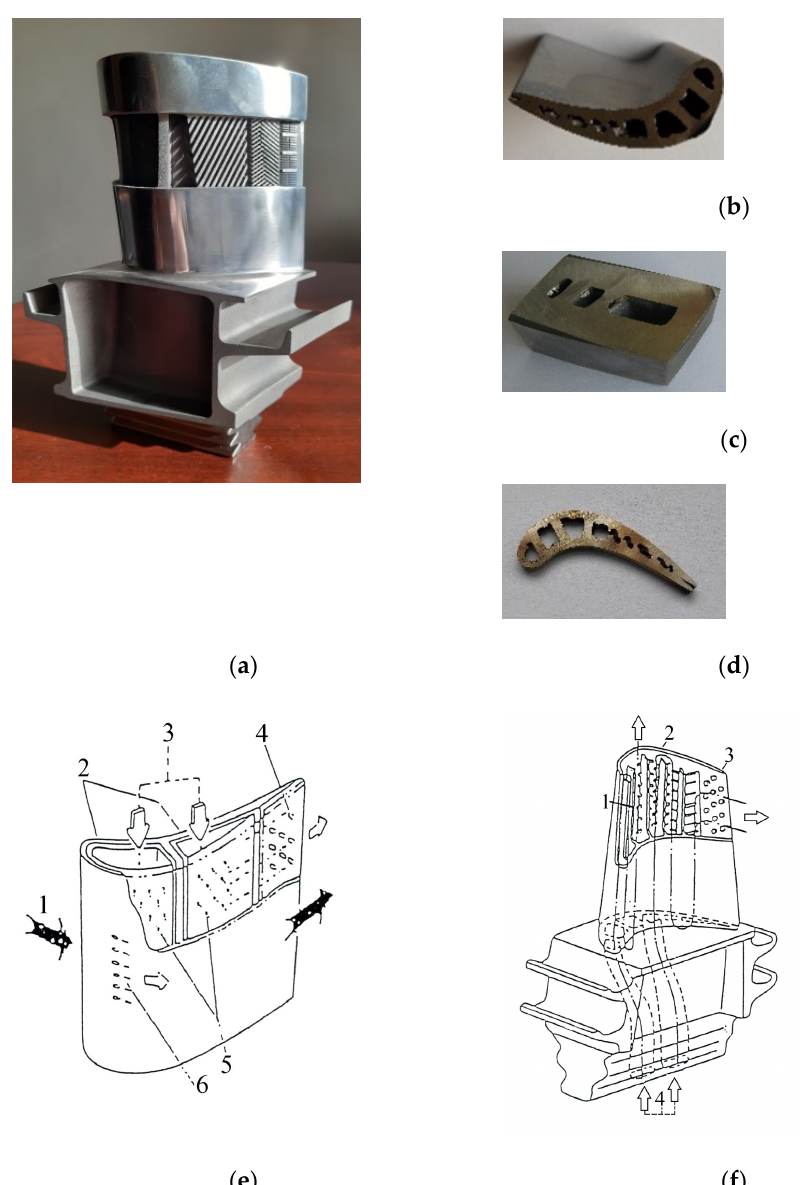
Figure 1. Blade of a DN80 power gas-turbine engine ( a ), cross-sections of its parts ( b – d ) and structure of the advanced cooling turbine blade: stationary blade (1—combustion gas, 2—core plug, 3—cooling air, 4—pin fin, 5—impingement cooling, 6—film cooling hole) ( e ); moving blade (1—turbulence promoter, 2—serpentine cooling channel, 3—pit fin, 4—cooling air) ( f ).